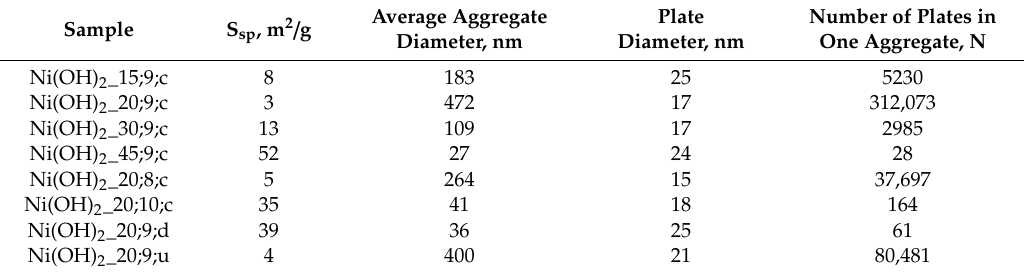
Table 3. Calculated parameters of the nickel hydroxide